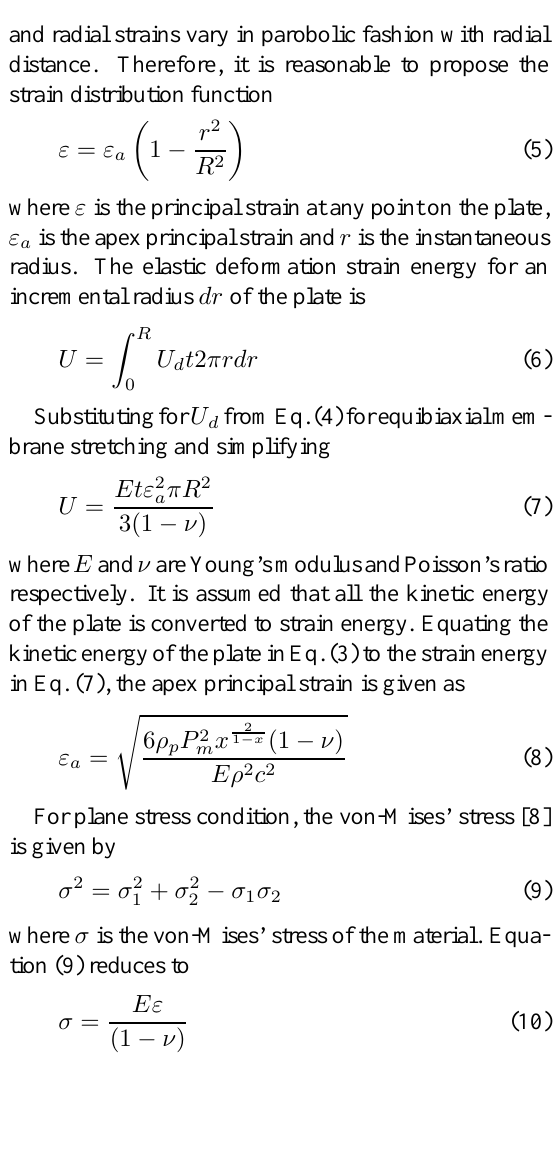
Fig. 4. Schematic of the experimental set up used for measuring the dynamic strains on the circular plate.